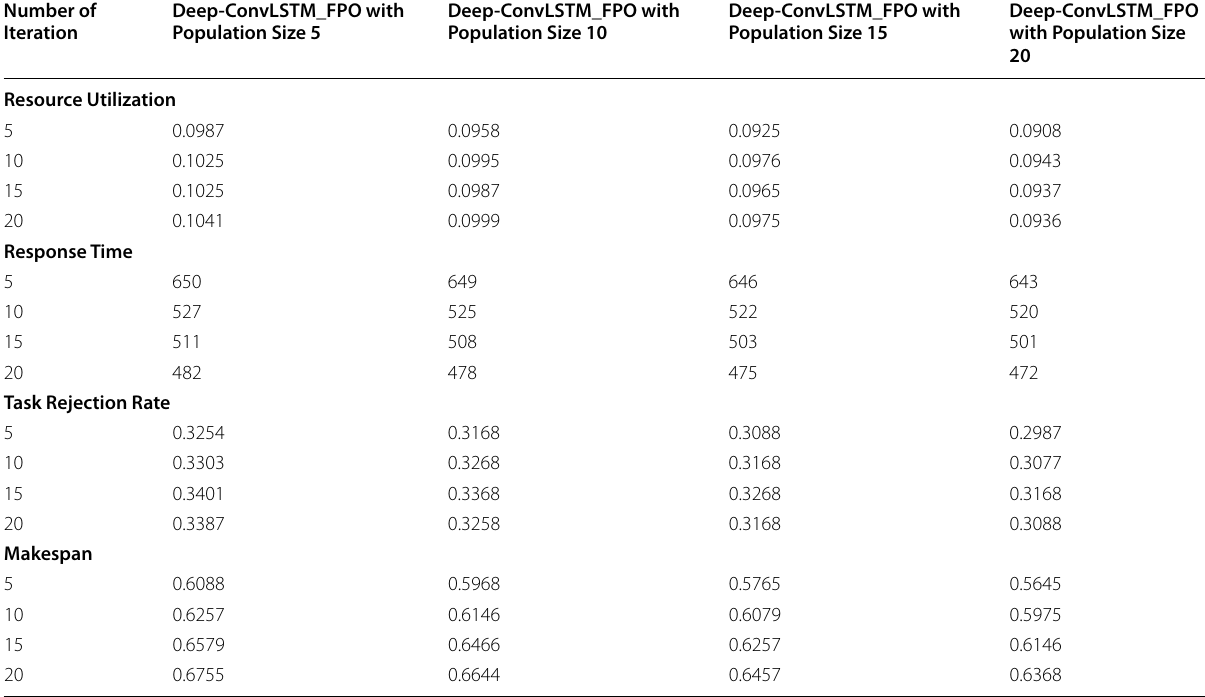
Table 4 Performance Assessment of Deep-ConvLSTM_FPO with Task Size